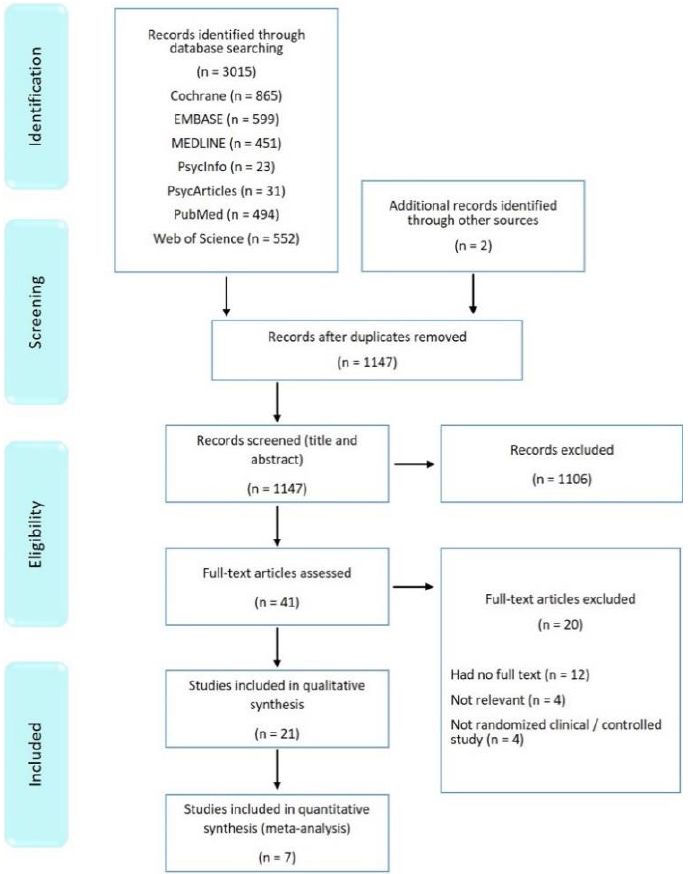
Figure 1. Flowchart of identification, screen, and assessing studies for inclusion eligibility.